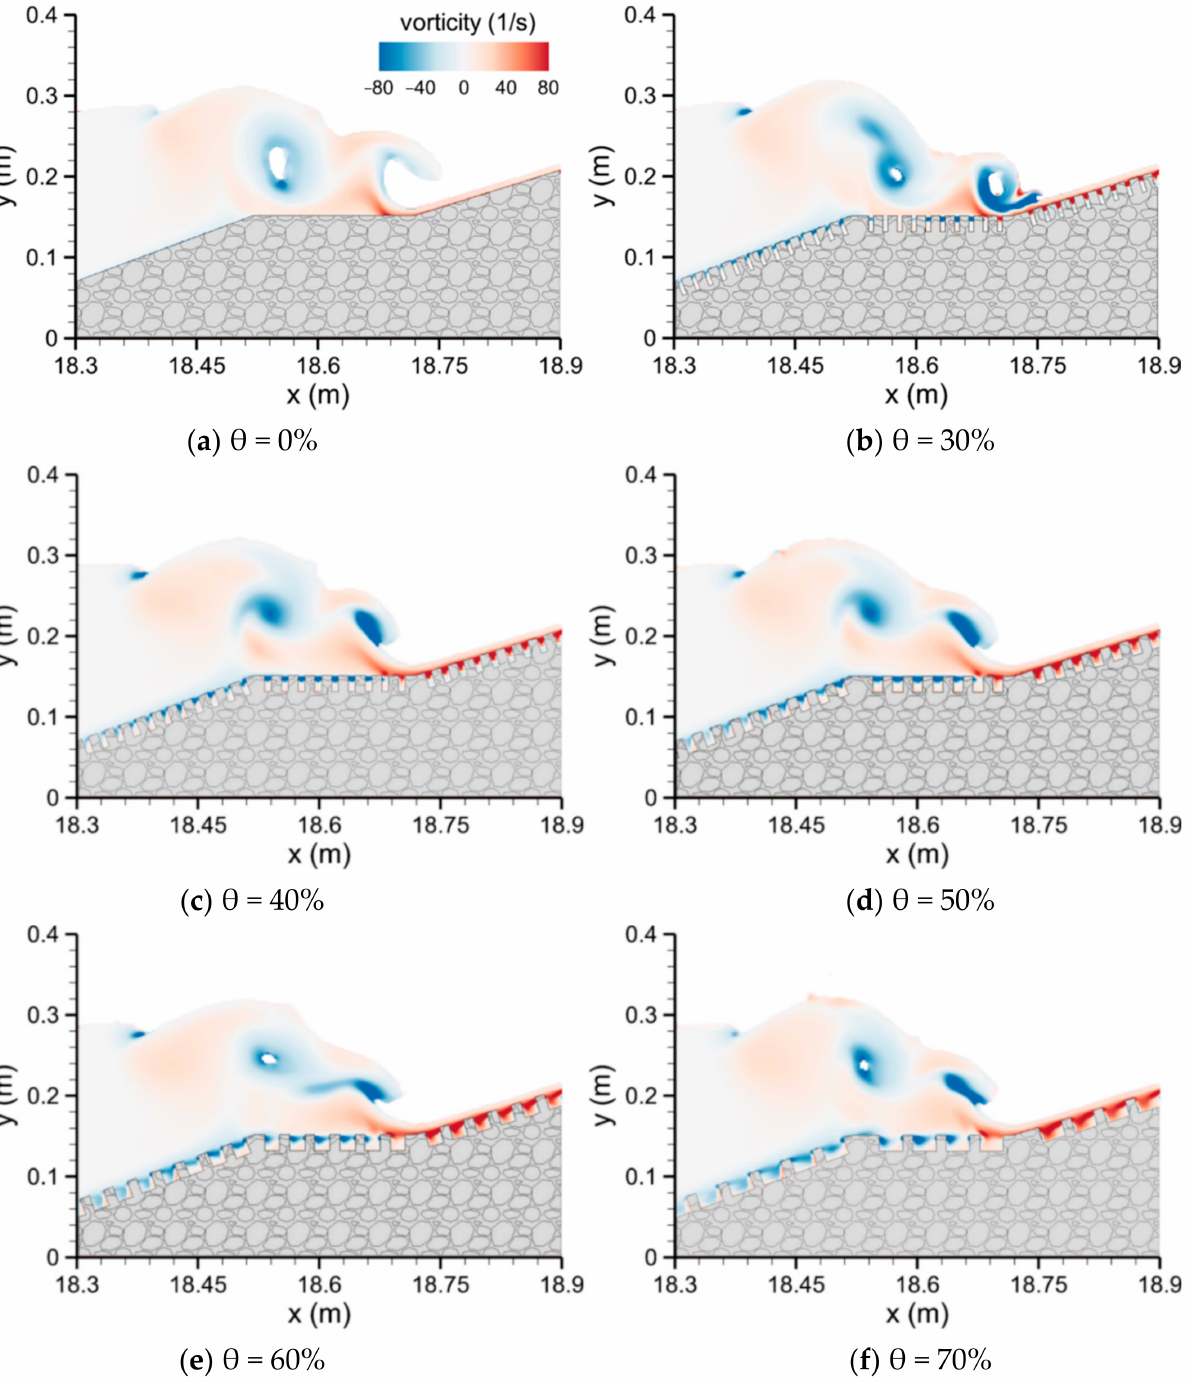
Figure 12. Vorticity distribution on the berm and its adjacent slopes for different gap ratios ( a – f